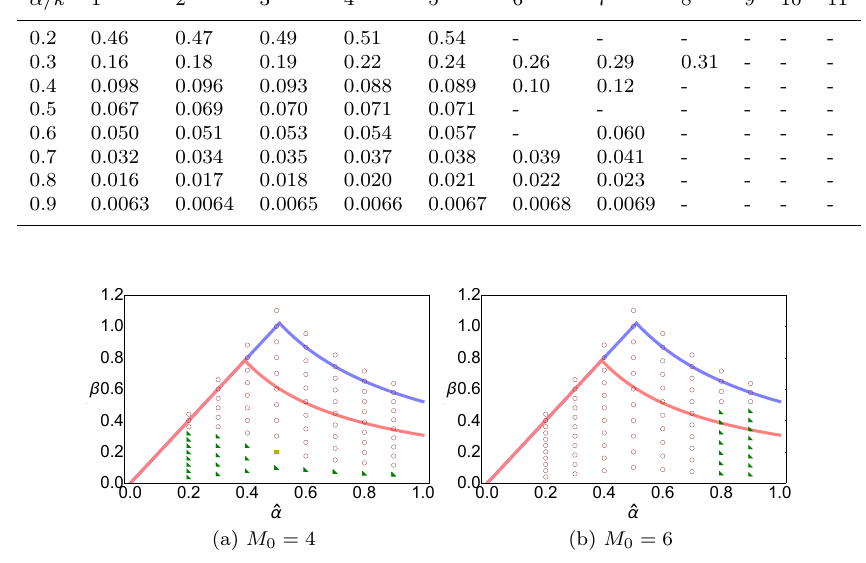
Table 2. The values δ V (the scheme B ) for various (cid:98) α and β = 0 . 1 k (cid:98) β nec ( (cid:98) α,M 0 ) and M 0 = 6 α/k